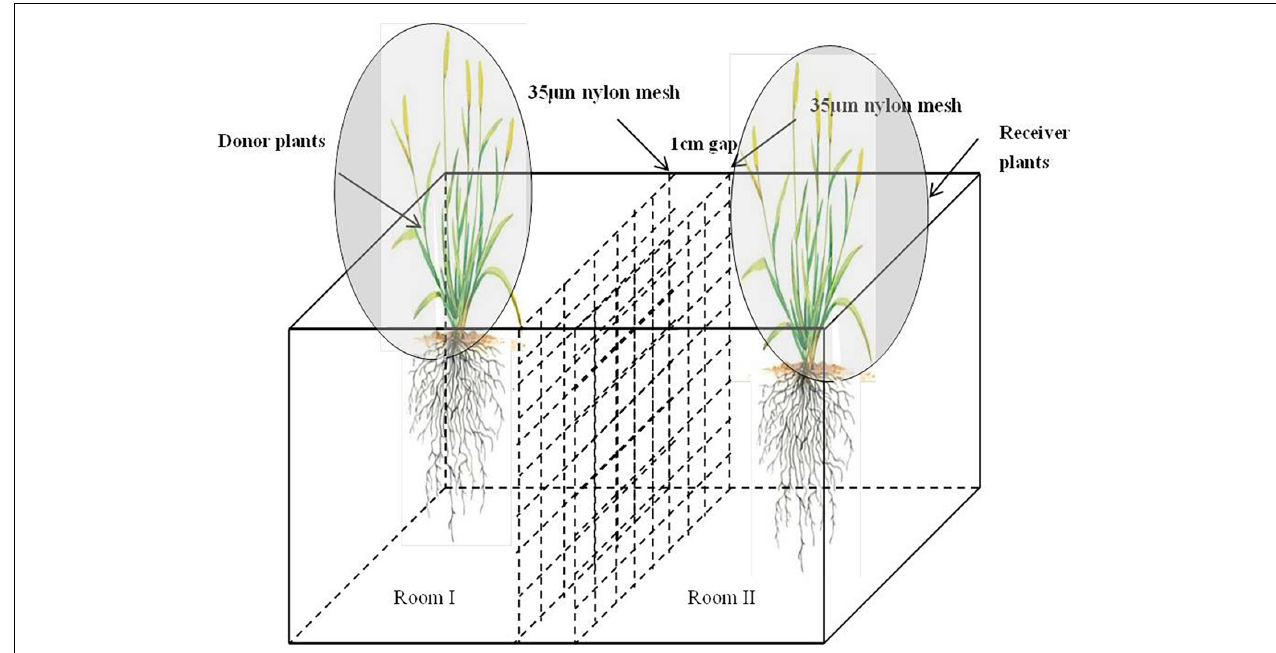
FIGURE 1 | Experimental